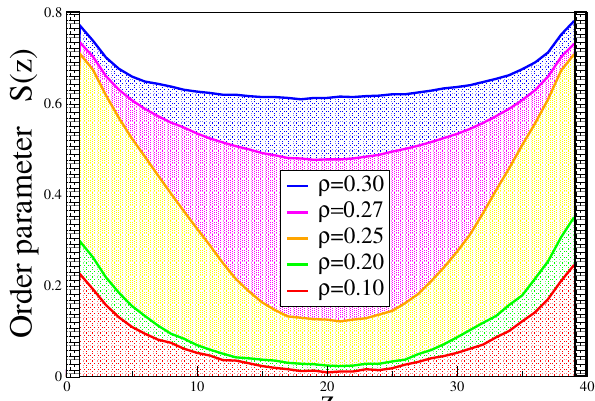
Figure 11. Thermally-averaged order parameter profile λ + ( z ) vs. distance z for the case N = 32, (cid:101) b = 32, L z = 40, N = 1500 and various densities, as indicated. Note that in the bulk, the I-N transition occurs at ρ tr ≈ 0.30. Reproduced from [45] with the permission of